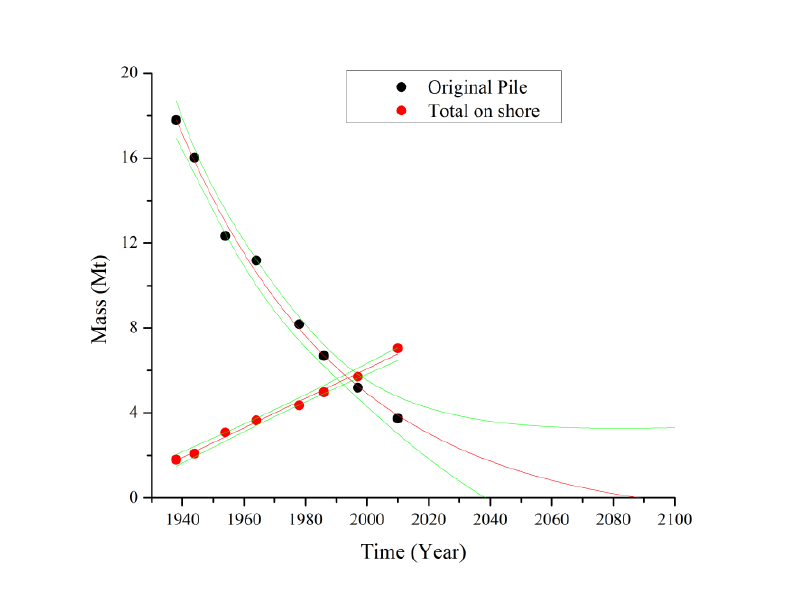
Figure 7. Aerial photo and LiDAR-derived estimates of erosion from the primary Gay tailing pile (black dots) through time and the corresponding accumulation of redeposited stamp sand on beaches south of the pile (red dots). Mass is in million metric tons (Mt), and 95% C.L. around regressions are indicated by green bands. The erosion of the pile closely fits an exponential decline function, whereas accumulation on the beach closely fits a linear increase